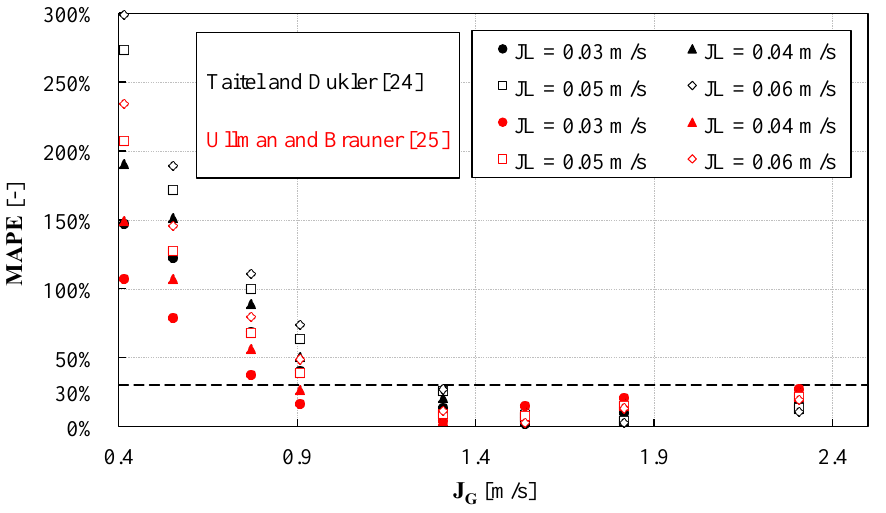
Figure 8. MAPE vs. superficial gas velocities at different superficial liquid velocities.